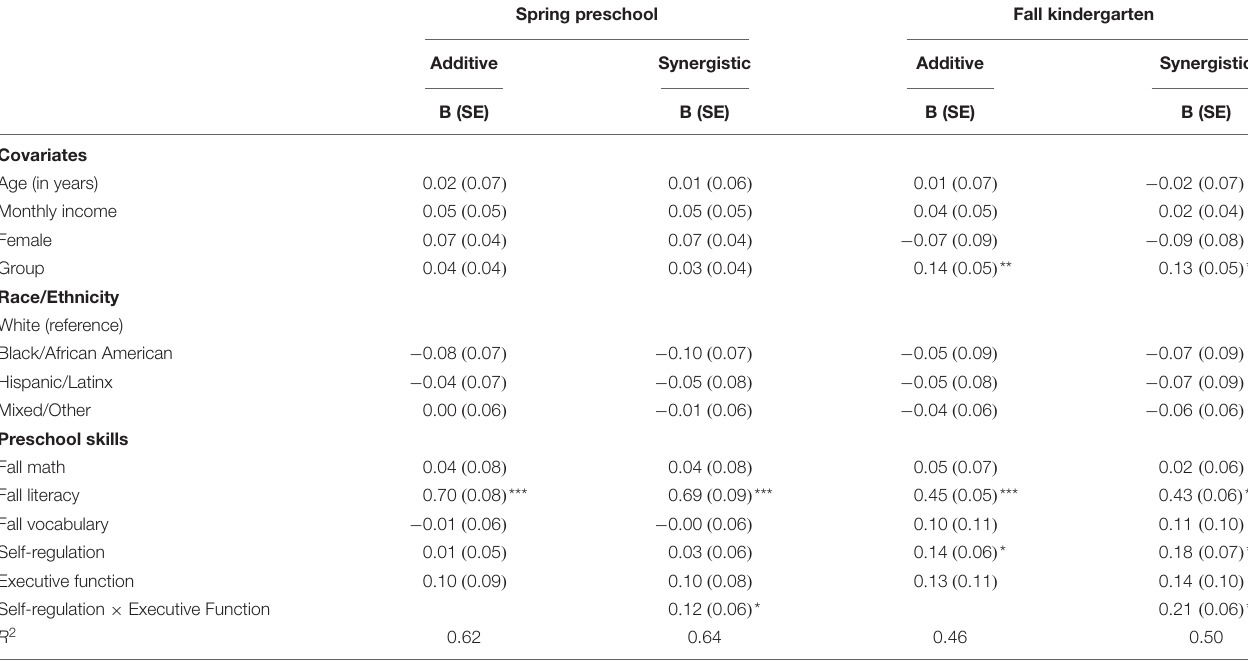
TABLE 4 | Model estimates for additive and synergistic effects of preschool self-regulation and executive function on literacy outcomes. Spring